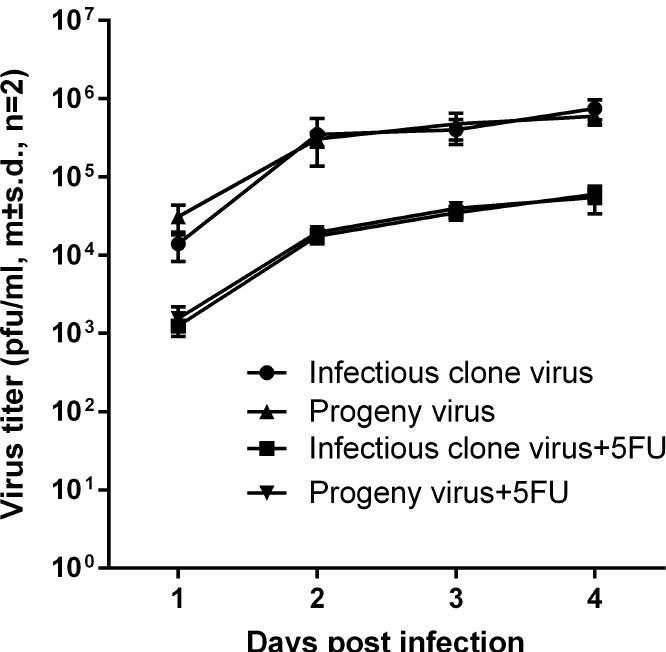
Fig 6. Effect of 5FU (20 μ g/ml) on the yield of virus in cultures of C6-36 cells infected at an MOI of 0.1 with infectious clone derived DENV1 or the progeny of the pre-extinction population of infectious clone derived DENV1 (open bar, P2, Fig